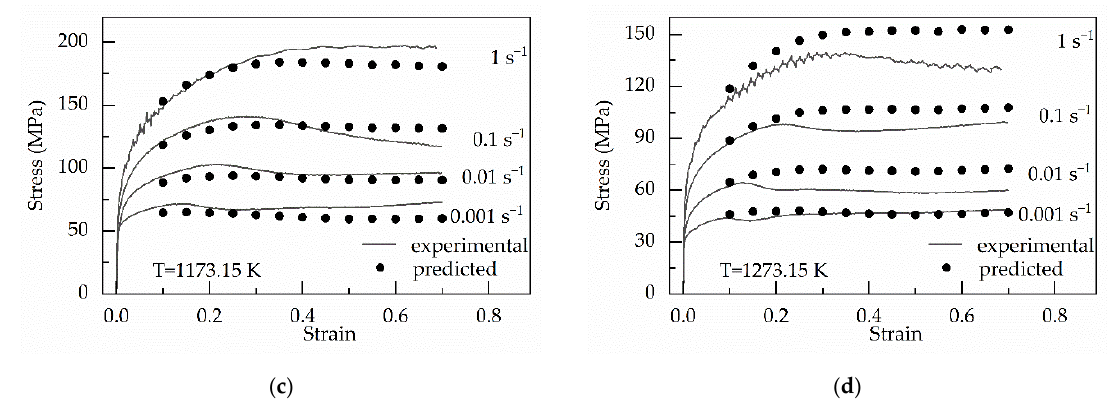
Figure 7. Comparison between the experimental and predicted stress by in the original strain-compensated Arrhenius-type (osA)-type equation at temperatures of ( a ) 973.15 K; ( b ) 1073.15 K; ( c ) 1173.15 K; ( d ) 1273.15 K.